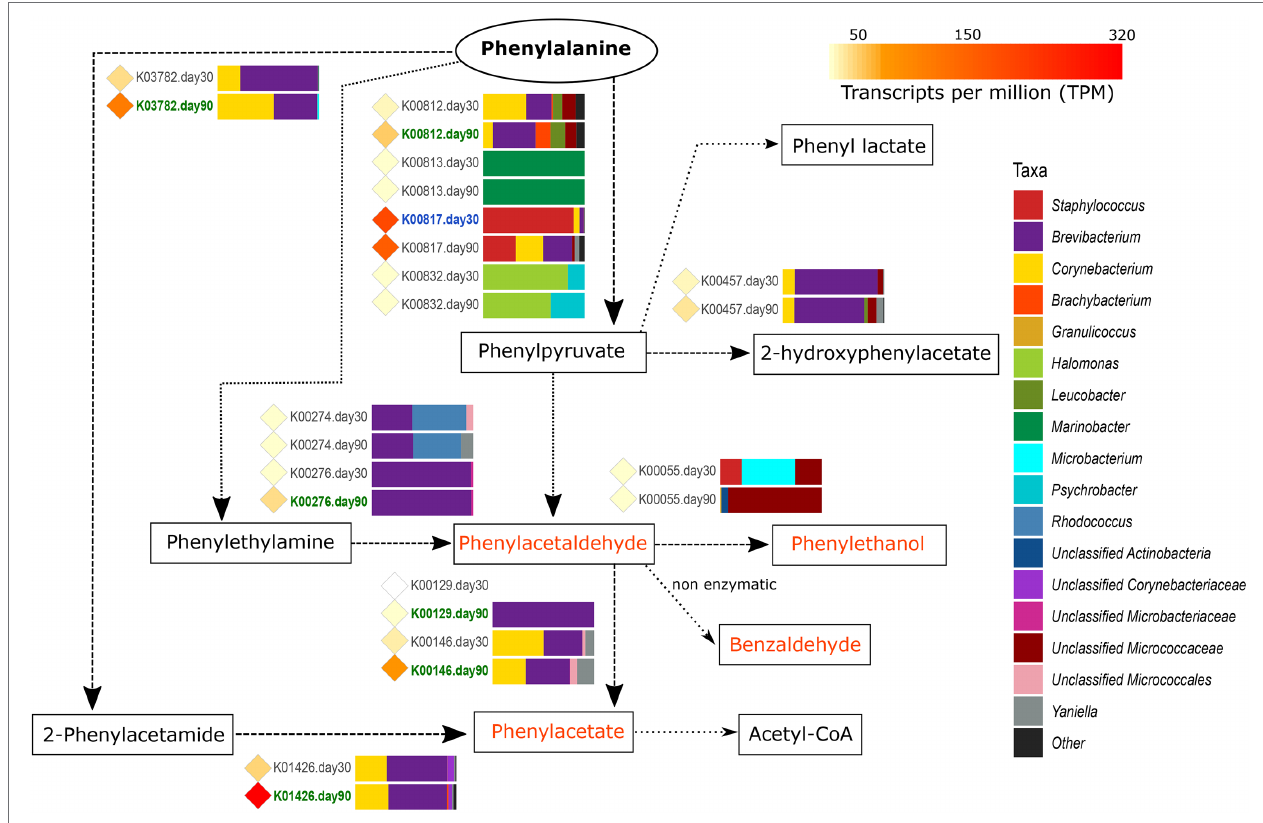
FIGURE 4 | Metabolism of phenylalanine. The different compounds that are generated in each metabolic pathway are showed and those harboring important organoleptic properties for cheese are colored in orange. The different metabolic pathways can be followed according to the corresponding arrows. Between every pair of compounds, the genes involved in such reactions are shown with their KO name. TPM values of each gene are shown as colored diamonds next to their corresponding KO name, which is colored in blue or green if significant transcription was identified for such KO day 30 or 90, respectively ( p < 0.05). Next to the KO names, the horizontal bar-plots represent the percentage of transcripts for that KO and ripening time that was associated with the different